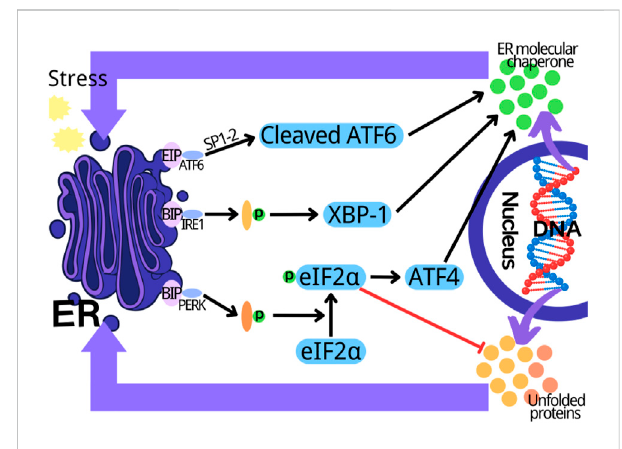
FIGURE 1 Three parallel signal transduction pathways in endoplasmic reticulum stress. PERK, pancreatic endoplasmic reticulum kinase; IRE1, inositol dependent enzyme 1; ATF6, activate transcription factor 6; XBP1, X-box binding protein 1; ER, endoplasmic